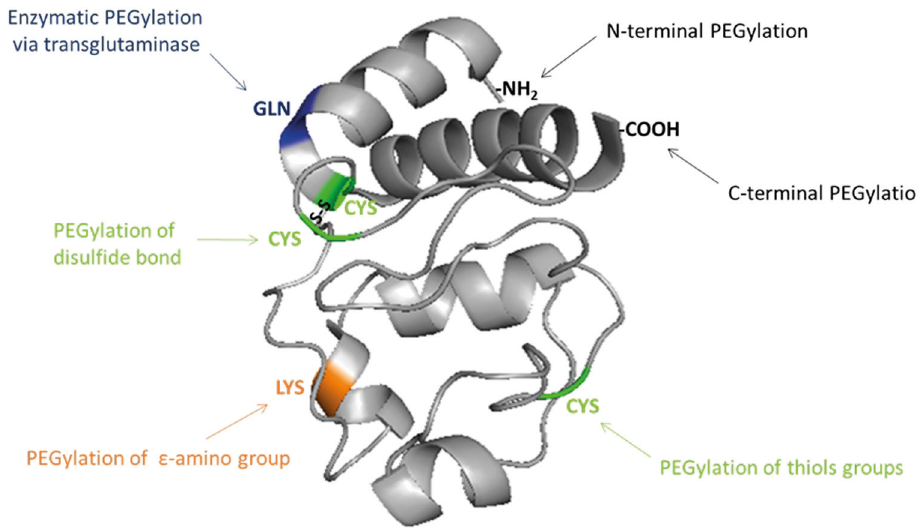
FIGURE 4 - Potential sites of PEGylation in proteins. Typical reactive amino-acids including lysine, cysteine, glutamine, N -terminal amino group and the C -terminal carboxylic acid are specific sites for conjugation with PEG derivatives.